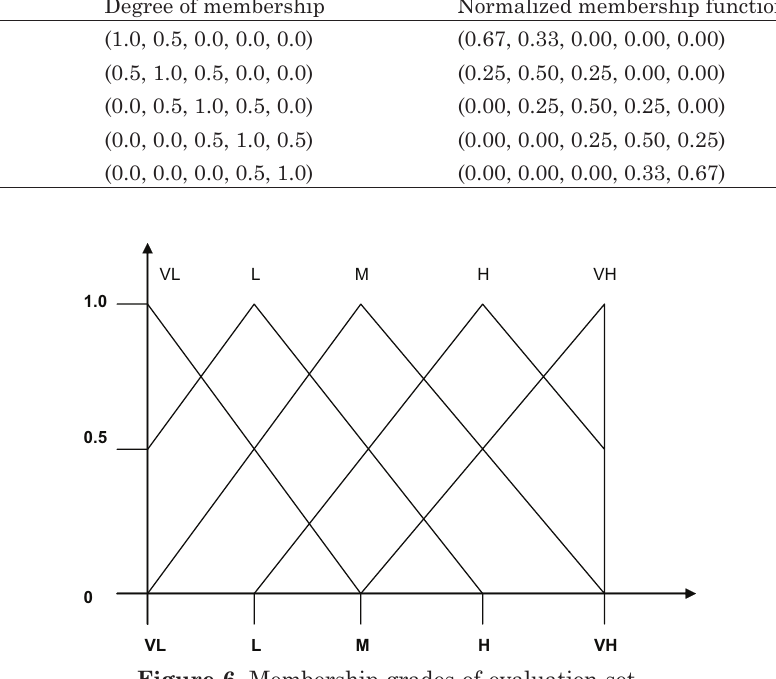
figure 6. membership grades of evaluation set